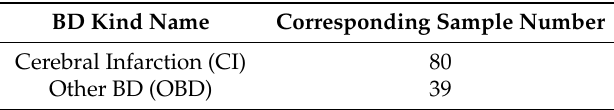
Table 1. Brain Disease (BD) types and its corresponding sample